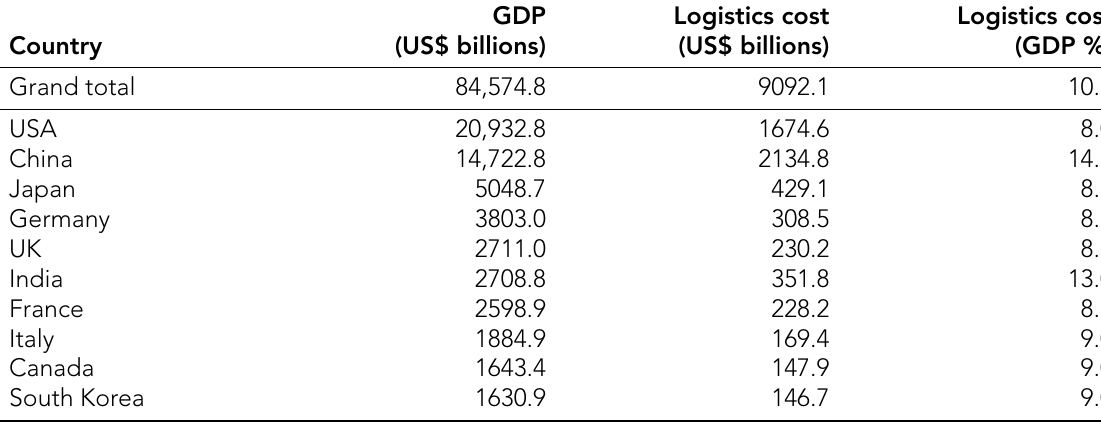
Table 1. The GDP, logistics costs and logistics costs as percentage of GDP of the top 10